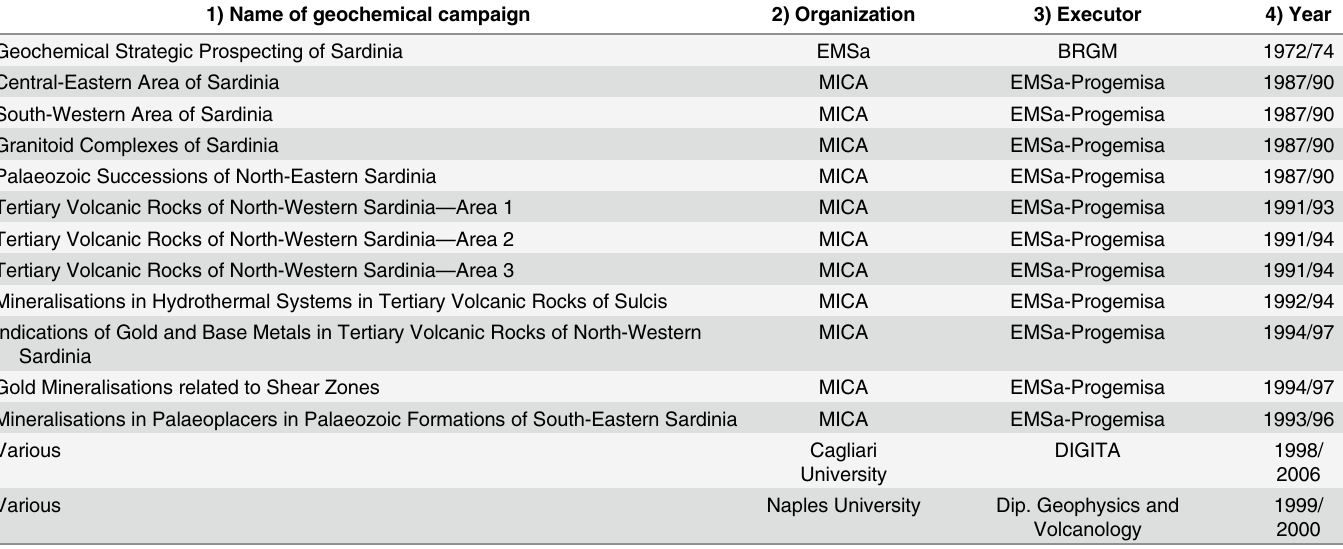
Table 1. Samples collected by Geochemical Campaigns in Sardinia (adapted from